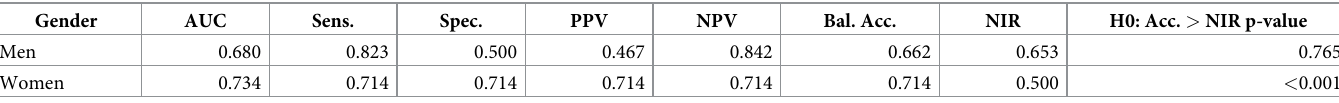
AUC = Area under the receiver operating characteristic curve. Sens. = Sensitivity. Spec. = Specificity. Bal. Acc. = Balanced Accuracy. PPV = Positive Predictive Value. NPP = Negative Predictive Value.